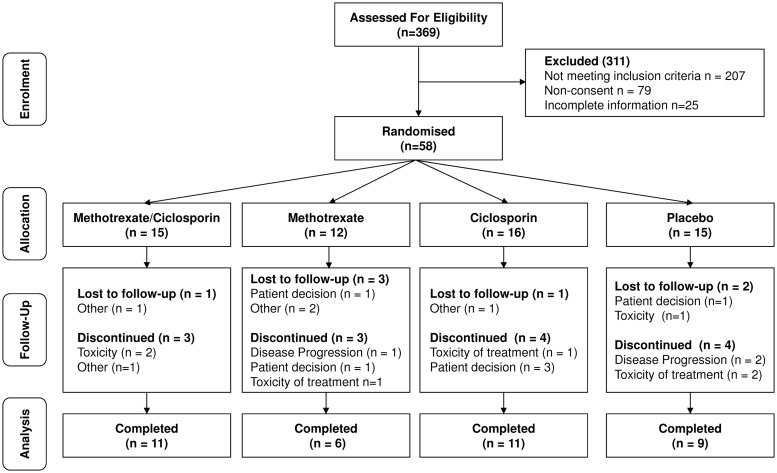
CONSORT flowchart for the SELAM trial